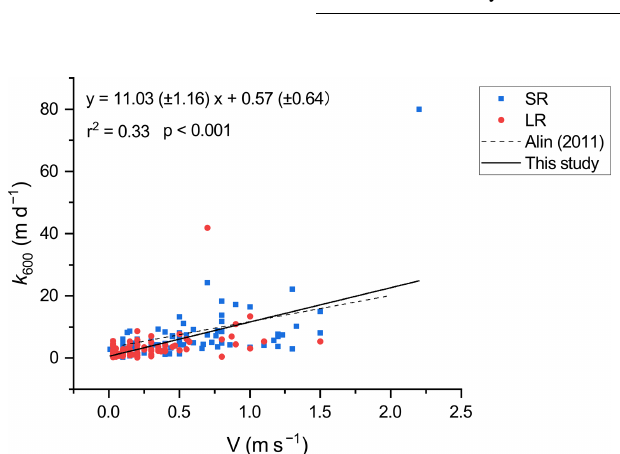
Figure 9. Relationship between k 600 and flow velocity. The dashed line represents the parameterization of Alin et al.